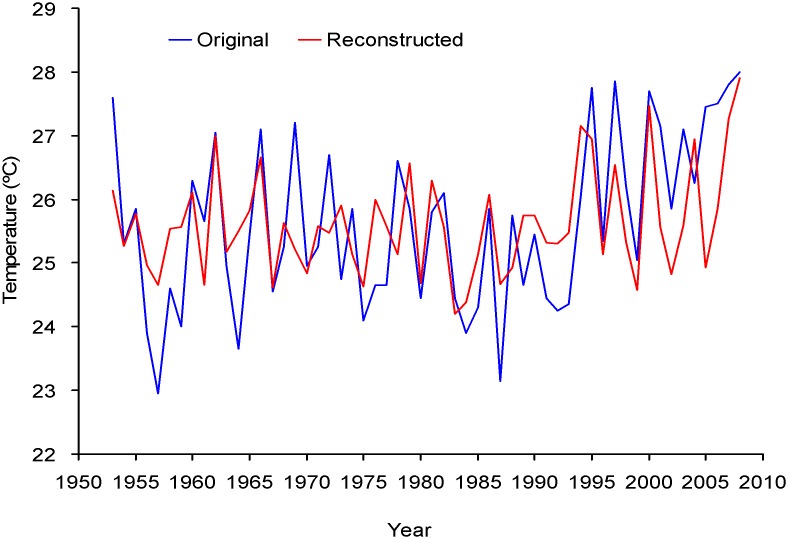
Comparison between observed and estimated spring (May to June) maximum temperature from 1953 to 2008.